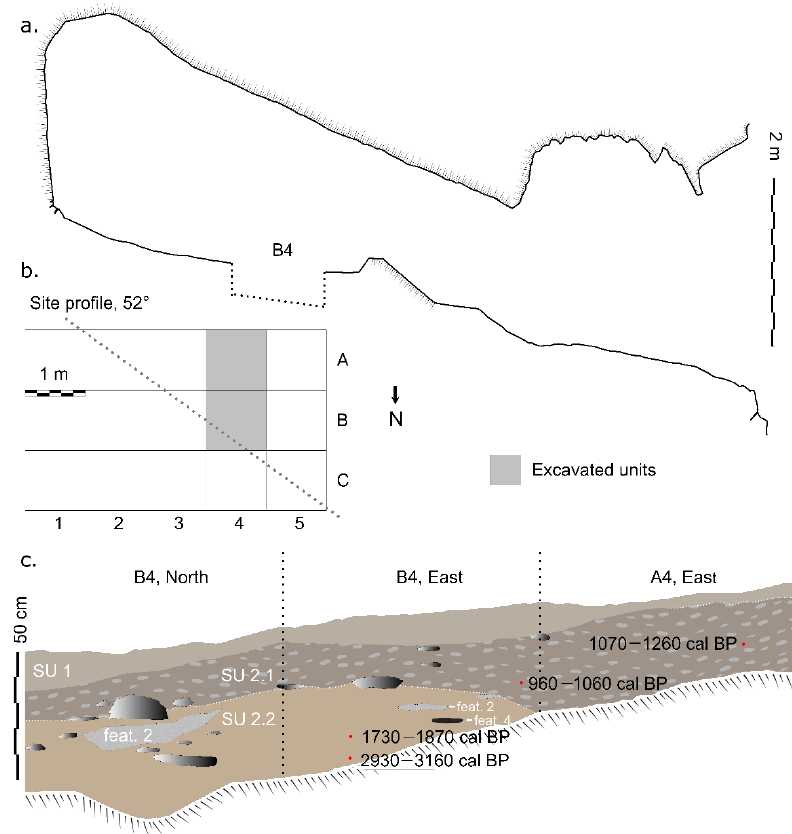
Figure 4. Archaeological features of the La Tina site; ( a ) cross section of the rock shelter; ( b ) excavated plan and location of the cross section of A; ( c ) stratigraphic section and radiocarbon chronology; feat: feature, SU: stratigraphic unit.